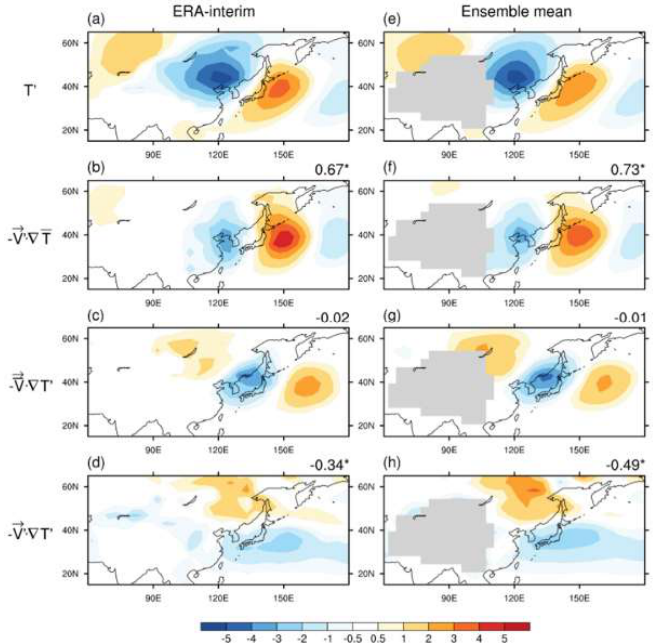
Figure 4. Composites for cold surge occurrence dates of the ERA-Interim ( a ) temperature anomalies ( ◦ C), ( b ) advection of climatological temperature by anomalous wind ( ◦ C day − 1 ), ( c ) advection of anomalous temperature by climatological wind, and ( d ) advection of anomalous temperature by anomalous wind at 850 hPa. ( e – h ) are same as ( a – d ) but for the ensemble mean of the nine CGCMs in the historical run. The spatial correlation coefficients between each advection term and temperature anomalies are shown in the top-right of each panel (values significant at 99% confidence level are represented by black